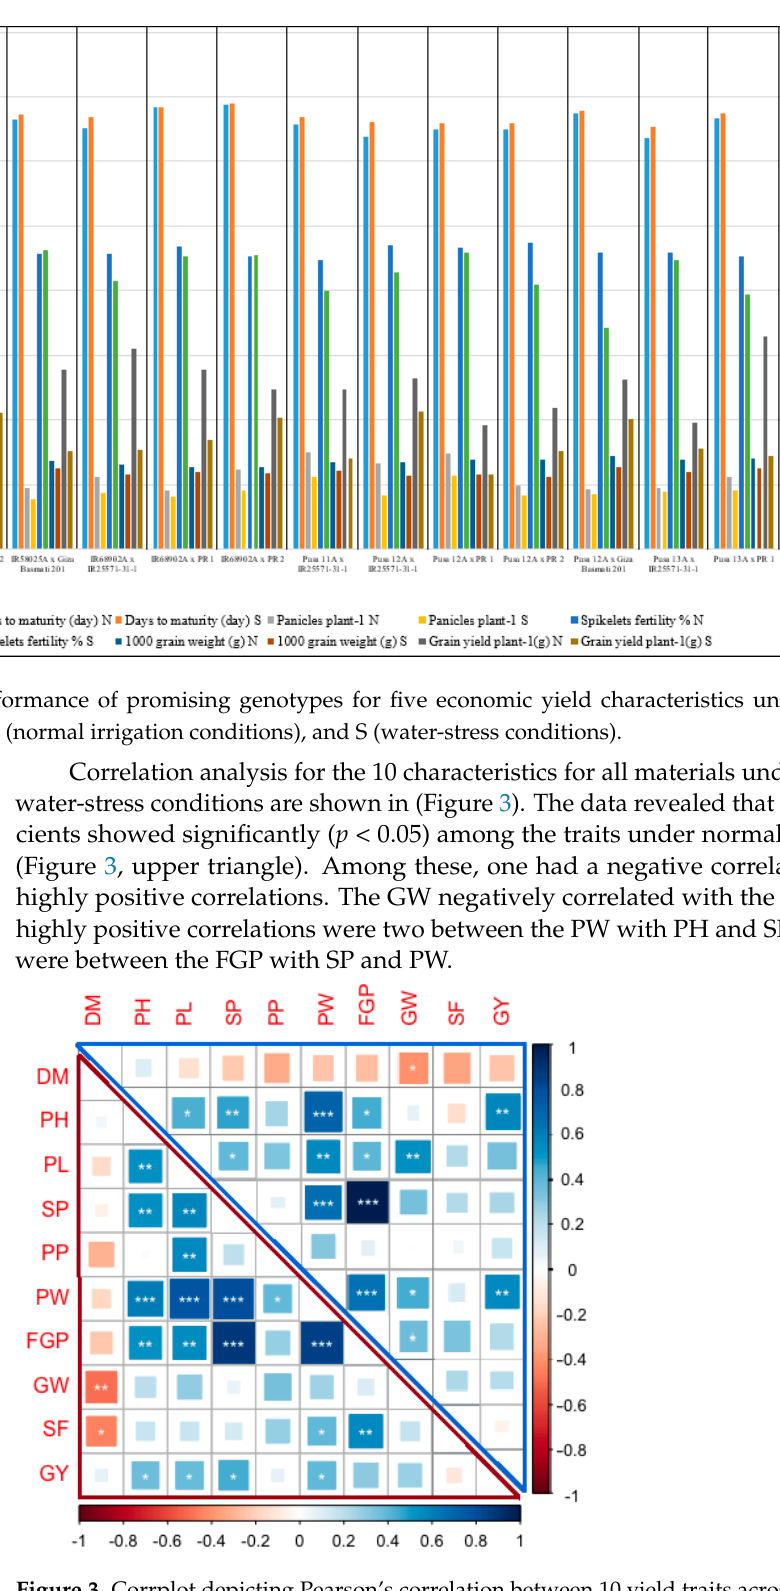
Figure 3. Corrplot depicting Pearson’s correlation between 10 yield traits across 29 genotypes under normal (upper triangle) and water-stress (lower triangle) conditions. Red squares indicate a negative correlation; blue squares indicate a positive correlation; and white squares indicate no correlation. The asterisks indicate significant correlations using a two-tailed t-test (** p < 0.05; and *** p < 0.01).